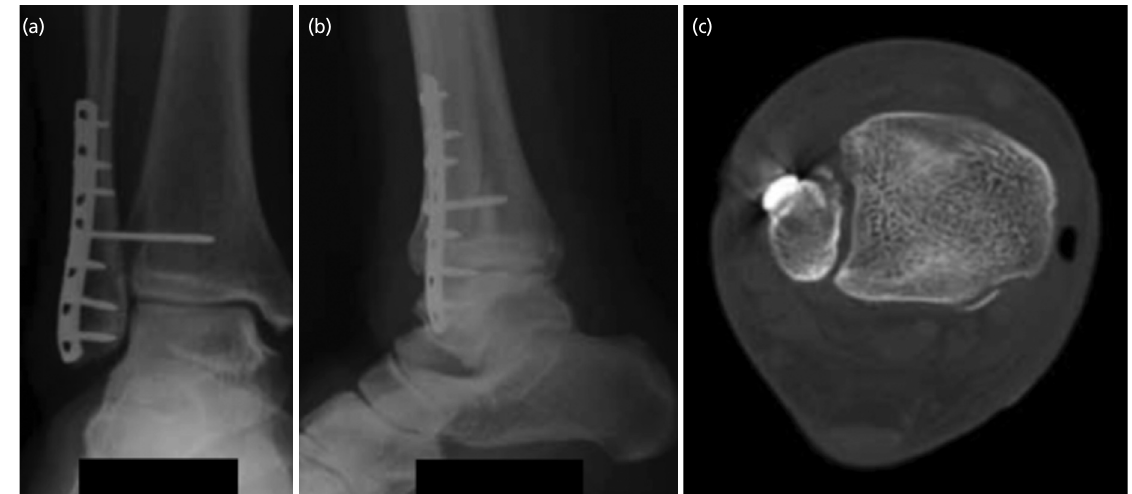
Fig. 2: Patient 1 – Post-operative (a) antero-posterior, (b) lateral and (c) axial computer tomography of the right ankle joint showing